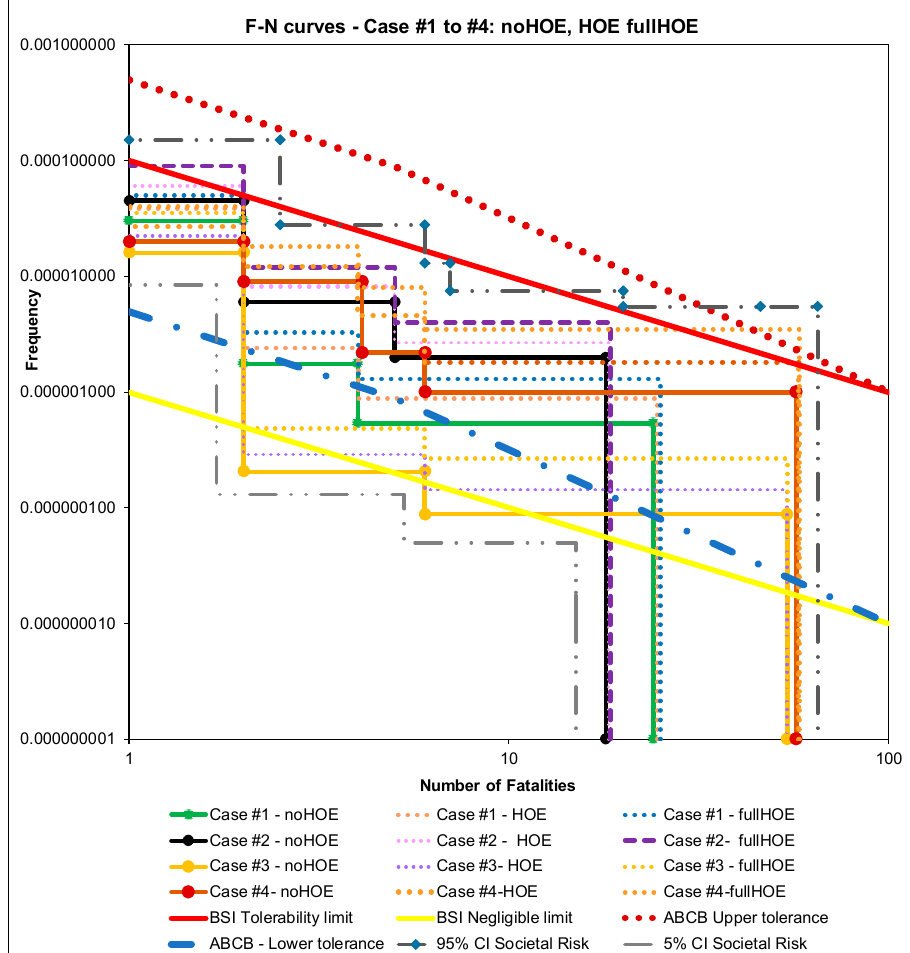
Figure 16. F-N curves for Case #1 to #4—Performance, HOE.